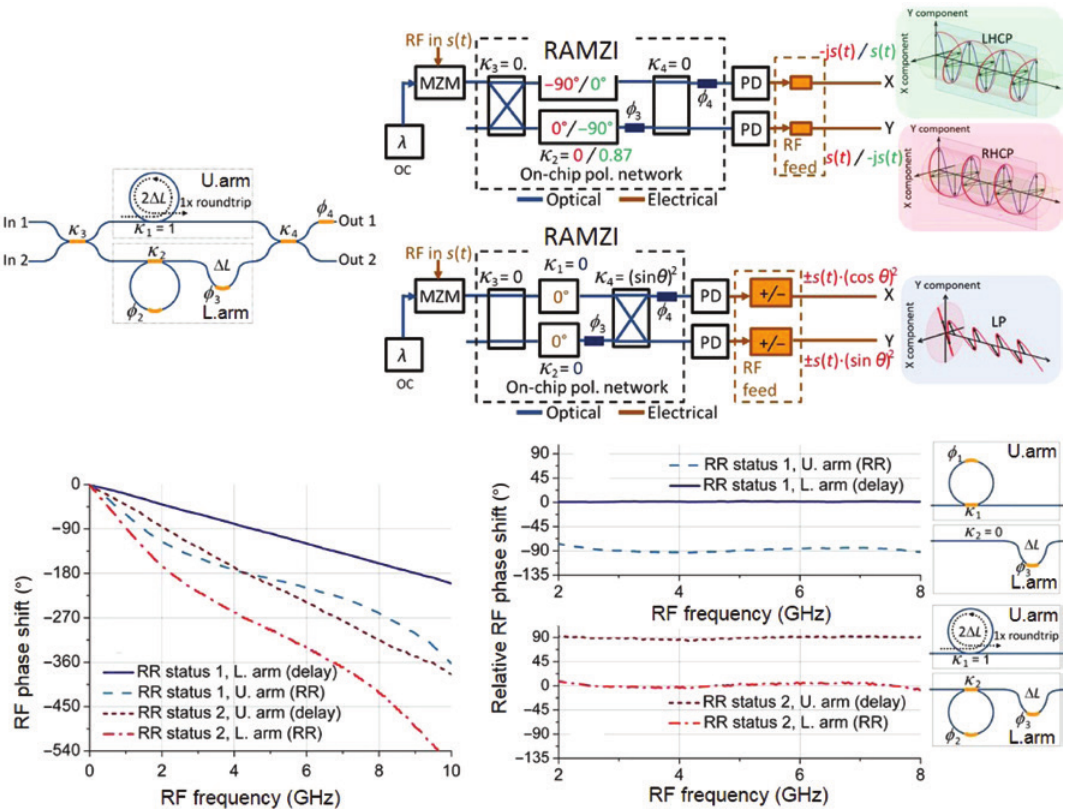
Figure 13: Design and realization of a highly reconfigurable RAMZI circuit: an application as a polarization network for dual-polarization linear antennas [79] (Copyright in 2013, Optical Society of